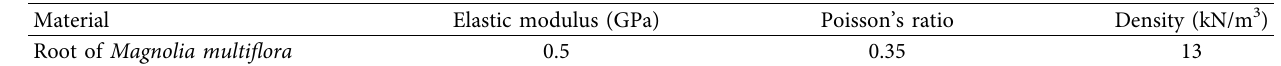
Figure 5: Schematic diagram of characteristic root scanning of Magnolia multiflora. Table 4: Physical and mechanical parameters of the root of Magnolia multiflora